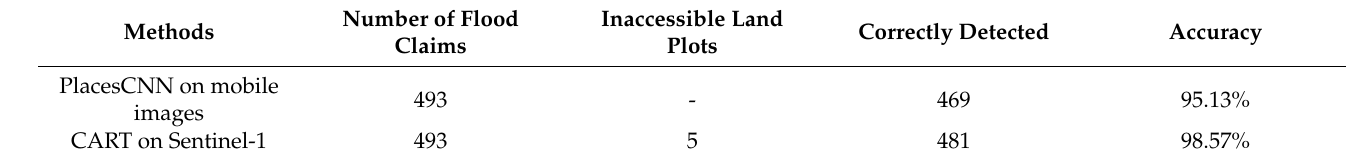
Table 5. Accuracy assessment using verified mobile images for flood detection with PlacesCNN on mobile images and the CART method on Sentinel-1 SAR GRD images for cloud-affected land plots in Sentinel-2A images.